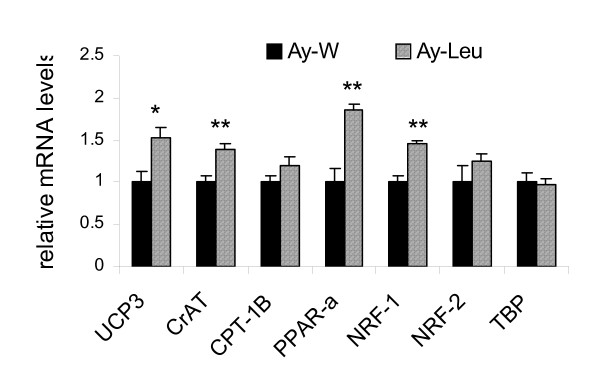
Leucine supplementation increases skeletal muscle expression of genes involved in regulating energy metabolism in Aymice. Messenger RNA levels of uncoupling protein 3 (UCP3), carnitine acetyltransferase (CrAT), carnitine palmitoyltransferase 1B (CPT-1B), peroxisome proliferator-activated receptor alpha (PPAR-alpha), nuclear respiratory factor 1 (NRF-1), nuclear respiratory factor 2 (NRF-2), and TATA-binding protein (TBP) were determined in the soleus muscle of young Ay mice after 4 months of treatment. The expression levels in leucine-treated mice are expressed relatively to the levels of the control mice. * and ** indicate p < 0.05 and 0.01, respectively, control vs. leucine-treated, n = 8.